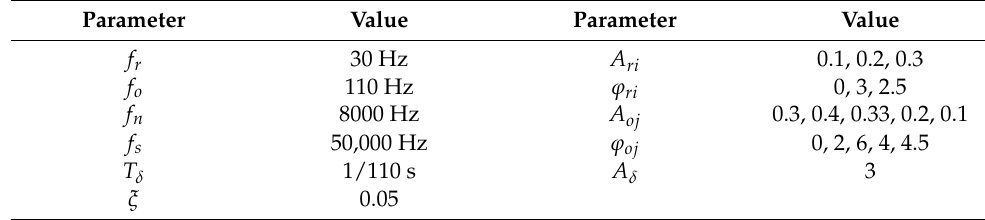
Table 1. The parameters in the single-fault vibration model.